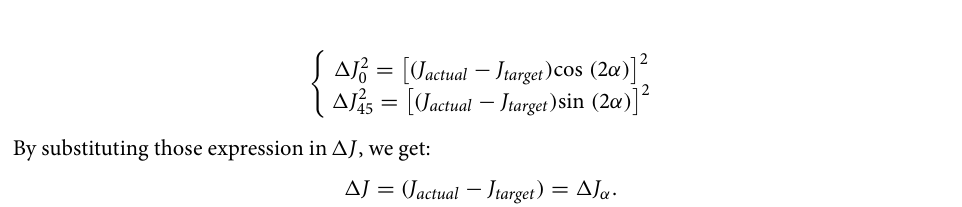
Figure 9. Area of clear vision for different PALs, metric (cid:31) J v . ( A ) Binary image showing area of clear vision (yellow) and area with (cid:31) J v more than ± 0.25D from the target prescription (blue). The calculations in each plot were based on data of four lenses with the same prescription. H Hoya, E Essilor, Z Zeiss. ( B ) Proportion of clear vision area as a function of PAL prescription. The proportion was calculated as area of clear vision to the total area of measurement. Error bars represent standard